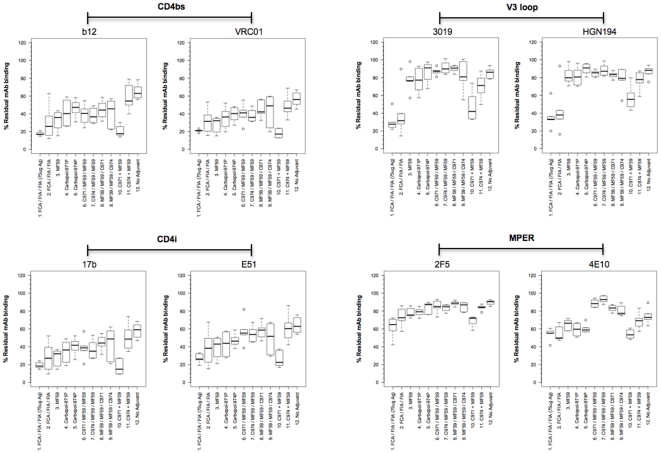
Antisera competition to different mAbs.Antiserum was used to compete with Eu-labeled mAbs specific for different antigenic domains of Env. The fluorescent signal of Europium is proportional to residual mAb binding, relative to the prebleed controls. A decrease in residual mAb binding indicated an increase in specificity of the antiserum for the epitope site. Both the FCA/FIA (groups 1&2) and the combination of Carbopol-971P and MF59 (group 10) displayed potent activities towards both CD4bs and CD4i and modest activities towards the V3 loop and MPER. By contrast, antisera from animals vaccinated with other adjuvants displayed only modest activities to CD4bs and CD4i and little, if any, towards V3 and MPER.